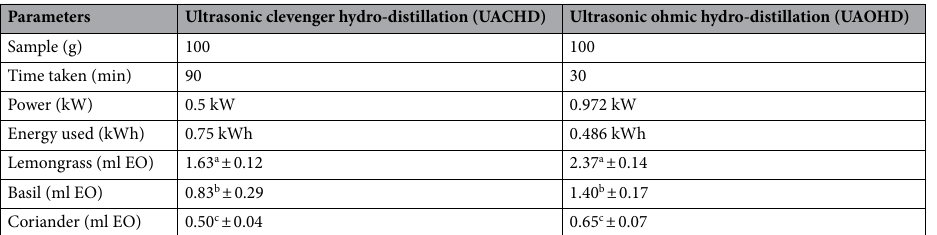
Table 3. Comparison of ultrasonic conventional hydro-distillation (UACHD) and ultrasonic ohmic hydro- distillation (UAOHD) processes. Different letters (a, b, c) for EOs among the aromatic plants spp. indicate significant differences at p ≤